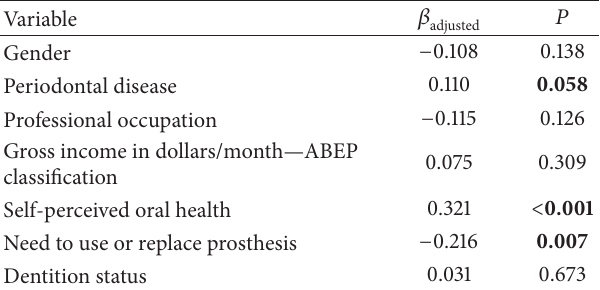
Table 4: Final result of the multiple linear regressions for patients treated in the Periodontics section at Dental Specialty